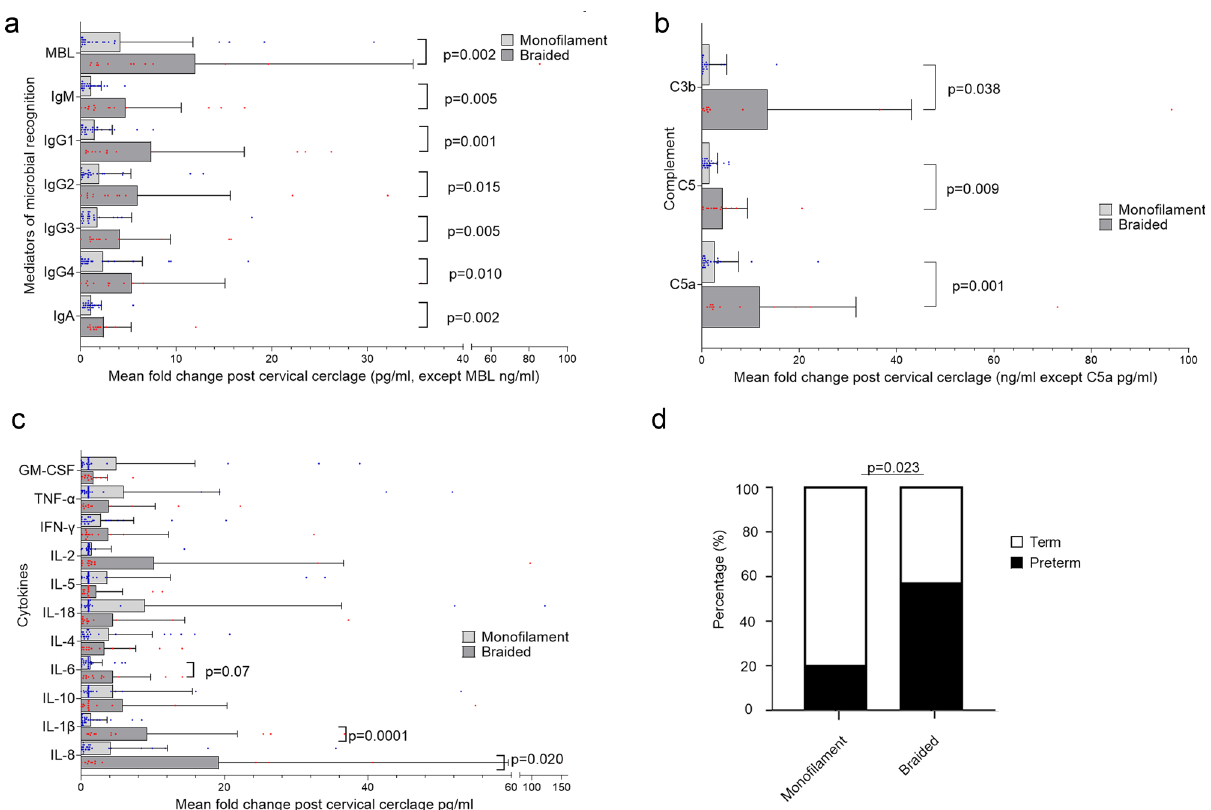
Fig. 8 Braided cervical cerclage material is associated with immune activation and higher rates of preterm labour. Cervicovaginal immune mediators were analysed from women pre- and post-cervical cerclage. The type of material was known for 39 women, 14 women received braided cerclage, and 25 women received mono fi lament. The fold change concentration of mediators of microbial recognition ( a ), complement proteins ( b ), and cytokine concentrations ( c ) between samples pre-cerclage and post-cerclage are compared between women who had braided cerclage ( n = 14) and women who had mono fi lament cerclage ( n = 25). The percentage of women who delivered preterm with a braided cerclage was compared with the percentage who delivered preterm following a mono fi lament cerclage ( d ). Statistical analysis was performed using a one-sided Mann – Whitney test and one-sided Fisher ’ s exact test. Data are presented as mean and standard deviation. Source data are provided as a Source Data fi